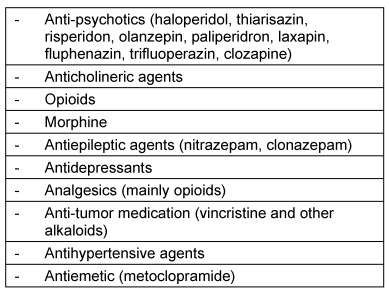
Centrally effective drugs possibly inducing or increasing dysphagia (according to [1, 36])